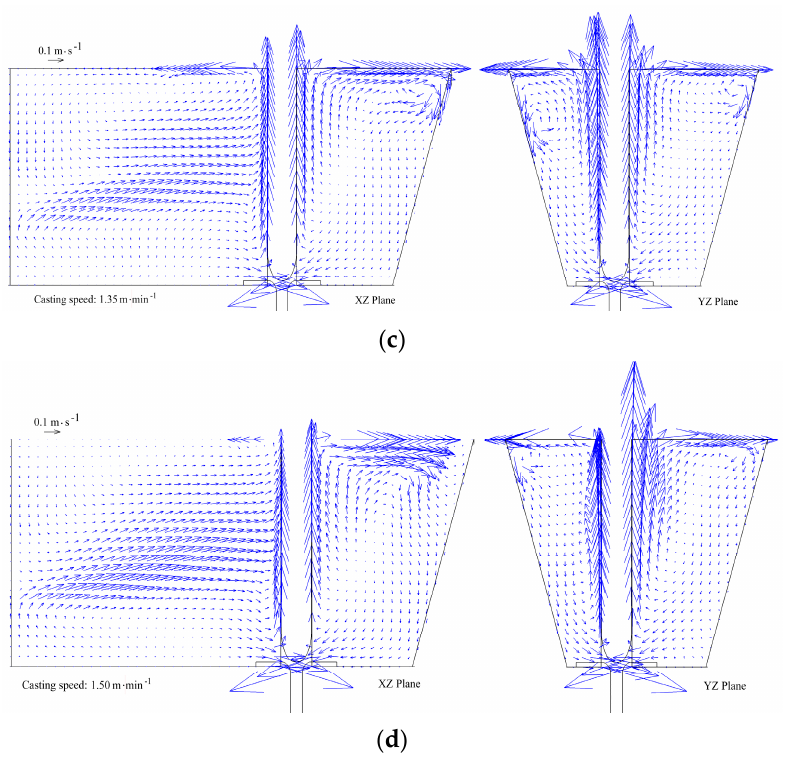
Figure 10. Flow behavior of liquid steel in the tundish under different casting speeds: ( a ) 1.05 m·min − 1 ,